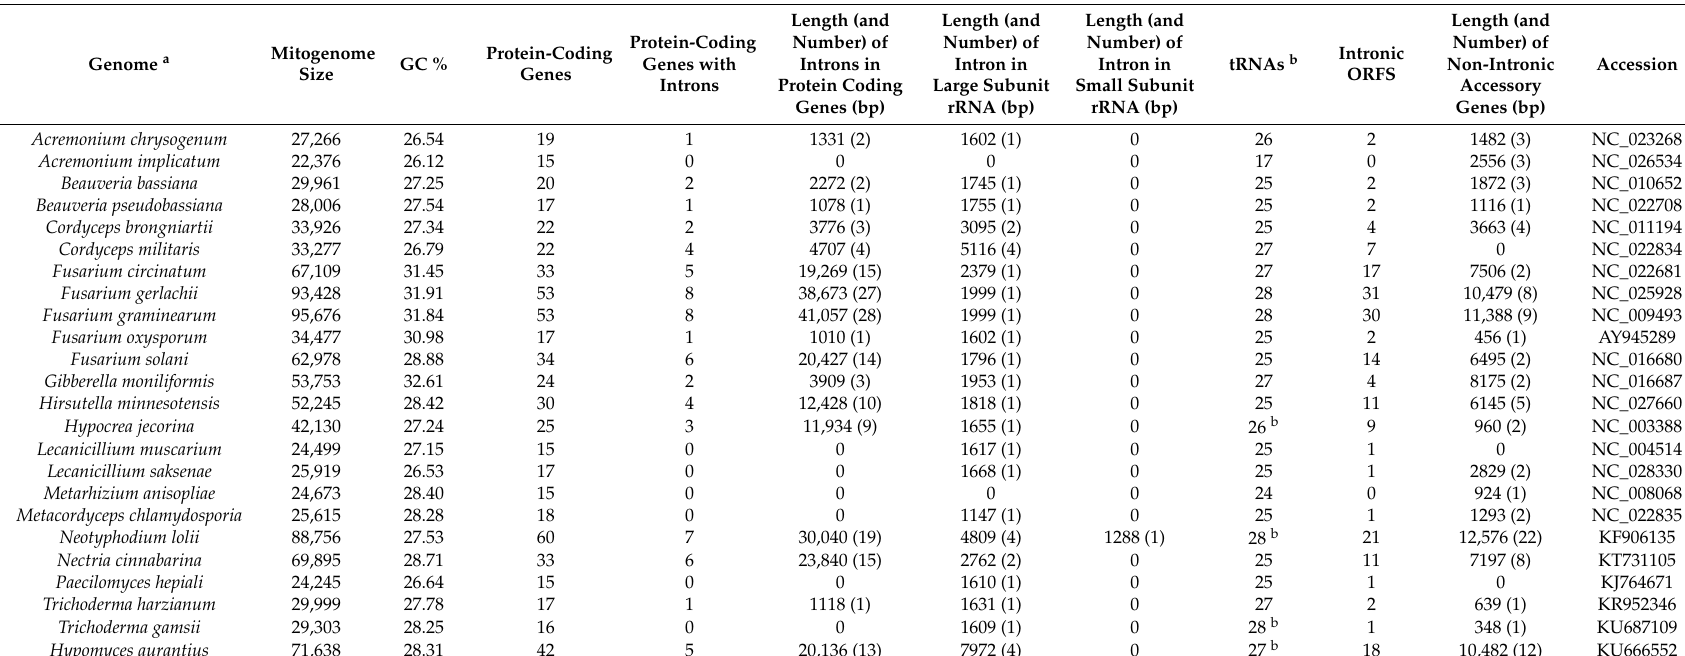
Table 2. Mitochondrial genomic comparison of 17 Hypocreales